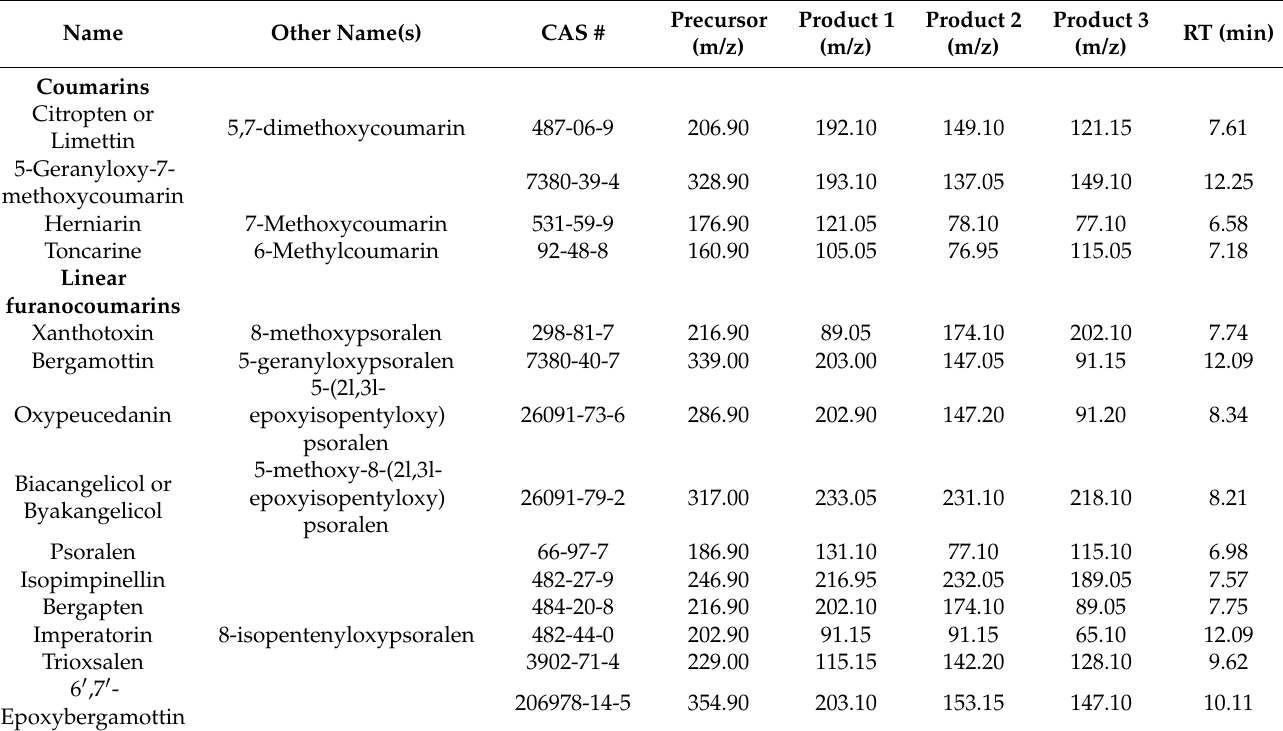
Table 5. Multiple reaction monitoring mode (MRM)